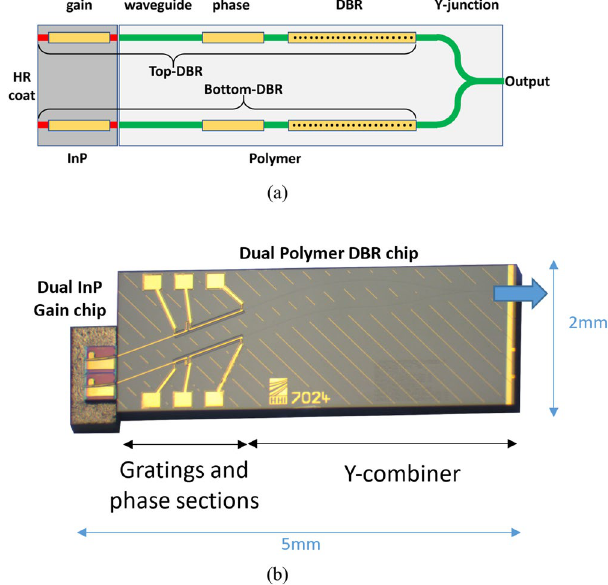
Figure 1. Hybrid integrated dual wavelength source chip, ( a ) Schematic showing the gain sections on InP and the elements on the polymer substrate, including passive waveguides, phase shifters and DBR sections and ( b ) photograph of the dual hybrid InP/Polymer DBR.